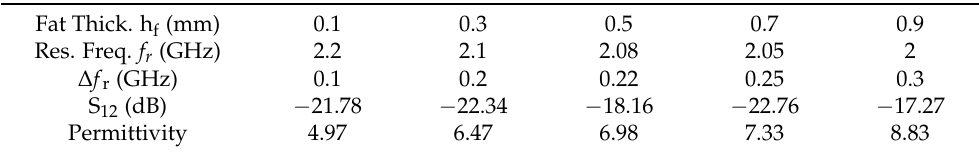
Table 2. Resonant frequencies, S 21 (dB) magnitudes, and dielectric constants for different fat layer thicknesses.